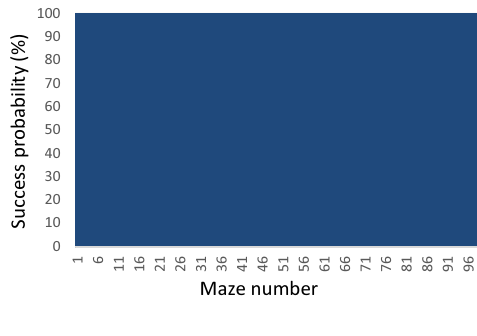
Figure 25: Result of 30000